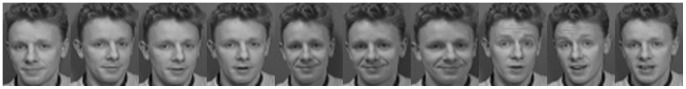
The face images of one subject in the ORL database.